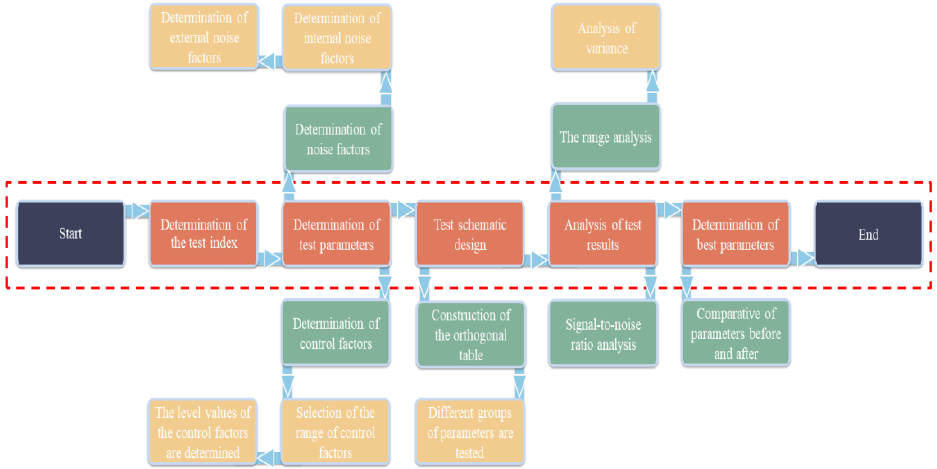
Figure 11. Implementation process of the Taguchi method.